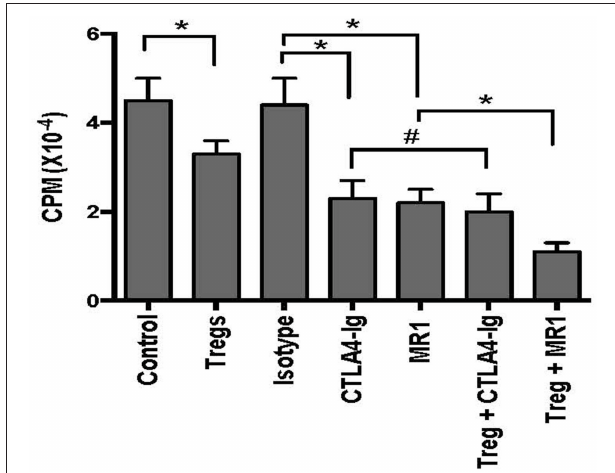
FIGURE 2 | CD8 + CD122 + PD-1 + Treg suppression of T cell proliferation in vitro. MLRs were set up as described in the methods to measure CD8 + CD122 + PD-1 + Treg suppression of T cell proliferation in vitro in the presence of either MR1 or CTLA4-Ig. Cells were harvested and analyzed using a Scintillation counter 5 days after the culture. Data are presented as mean ± SD. One representative of three separate experiments is shown (* P < 0.05 and # P > 0.05).